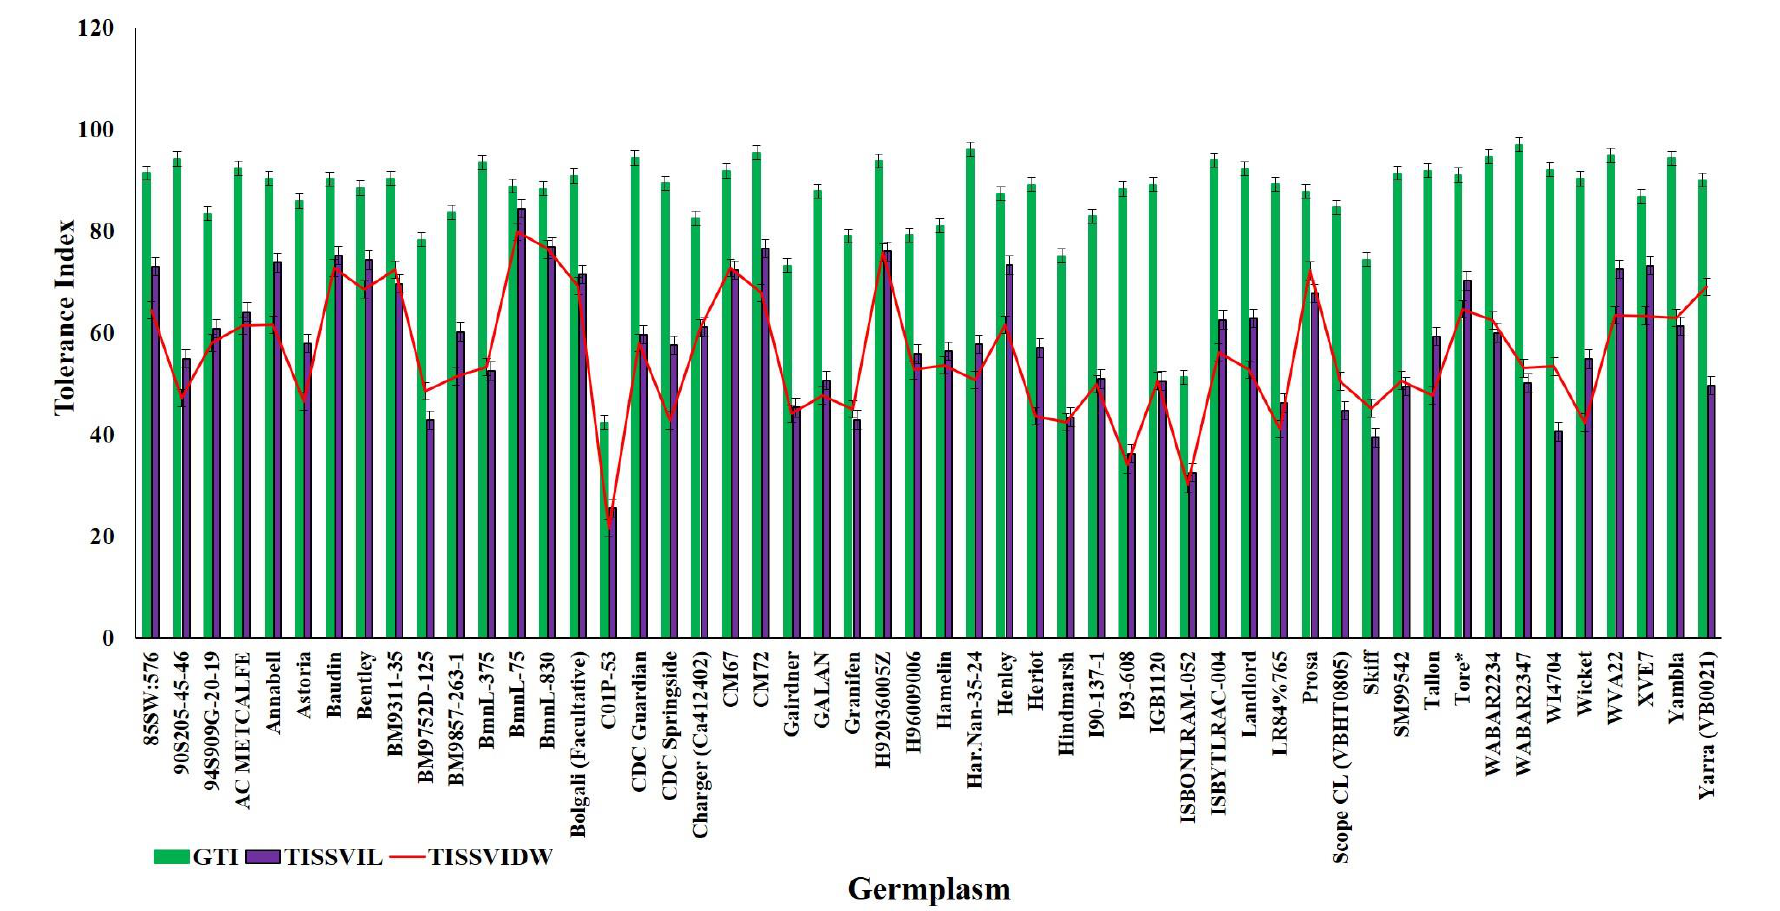
Figure 3. Representation of the highly tolerant and extremely sensitive 15 genotypes for germination tolerance index (GTI; blue line), Relative seedling vigour index by length (RSVIL; red line) and Relative seedling vigour index by DW (RSVIDW; green line).